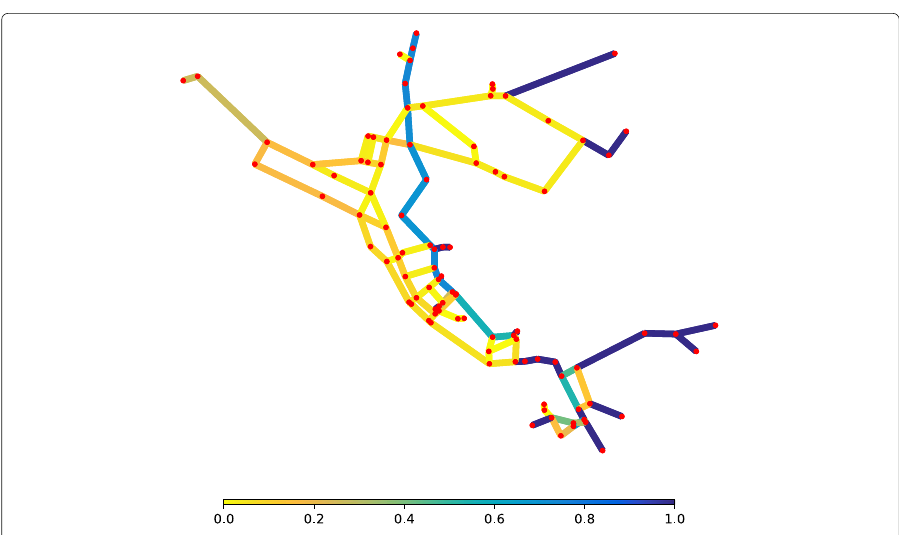
Fig. 2 WFEBC of Net3 links. The betweenness of each link is weighted by customer demand and normalised by the maximum total flow it would have to support if there were no alternative paths to yield a measure of WFEBC. The darker the link, the more